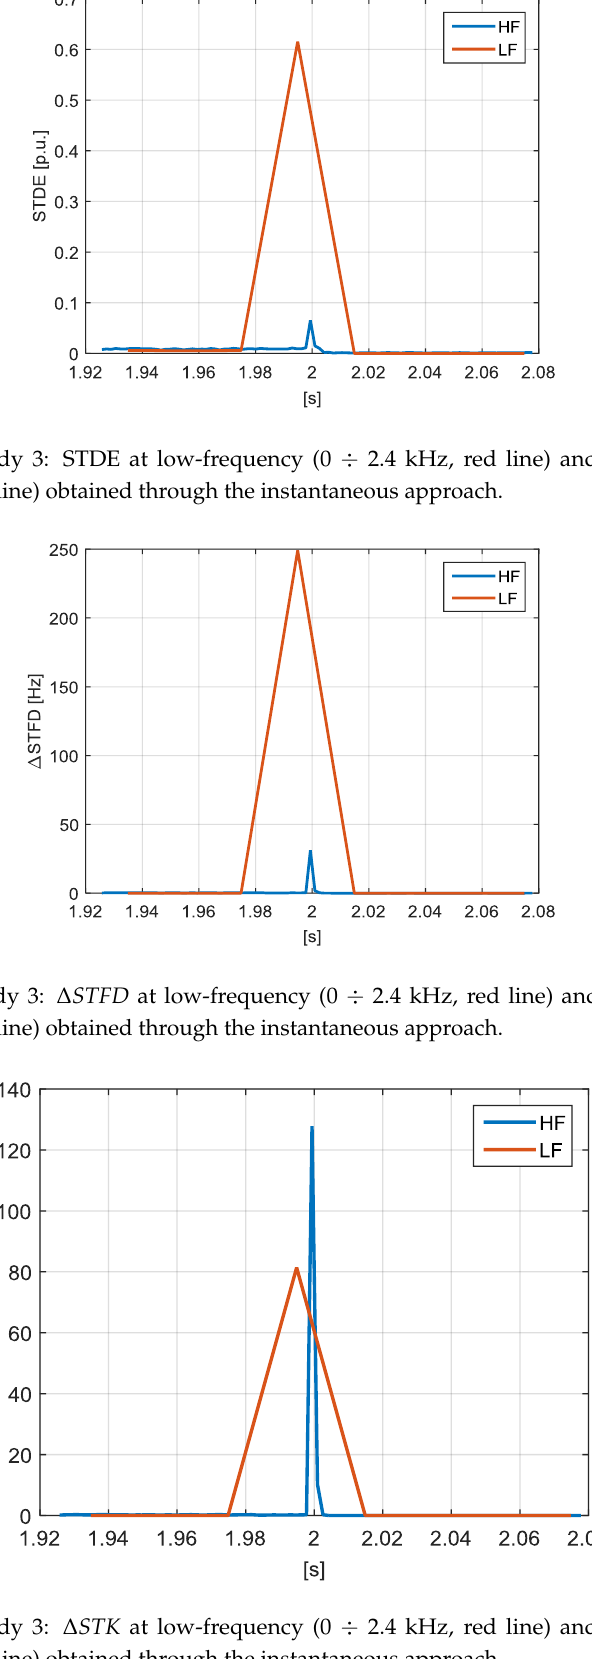
( c ) Figure 18. Case study 3: time trends of the waveform under study in terms of ( a ) original waveform,